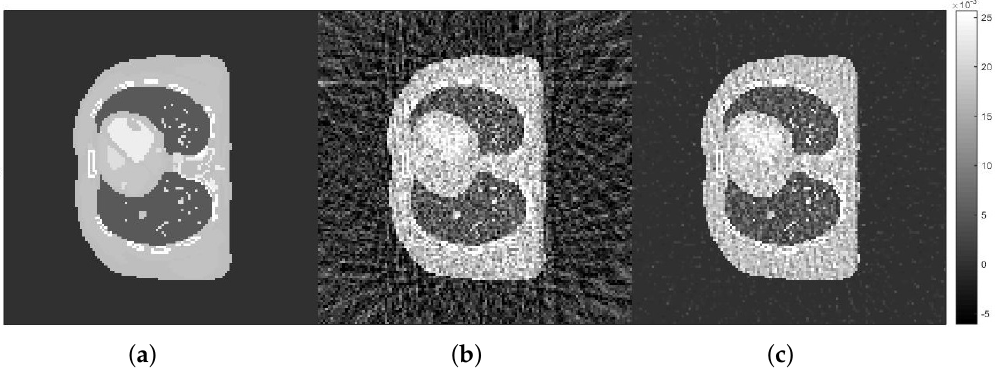
Figure 3. Cross-sectional images from ( a ) the exact phantom image, ( b ) the FDK algorithm and ( c ) the AwPCSD algorithm with randomly chosen hyper-parameters ( ng = 1, (cid:101) = 500, β = 1, β red = 0.99, δ =